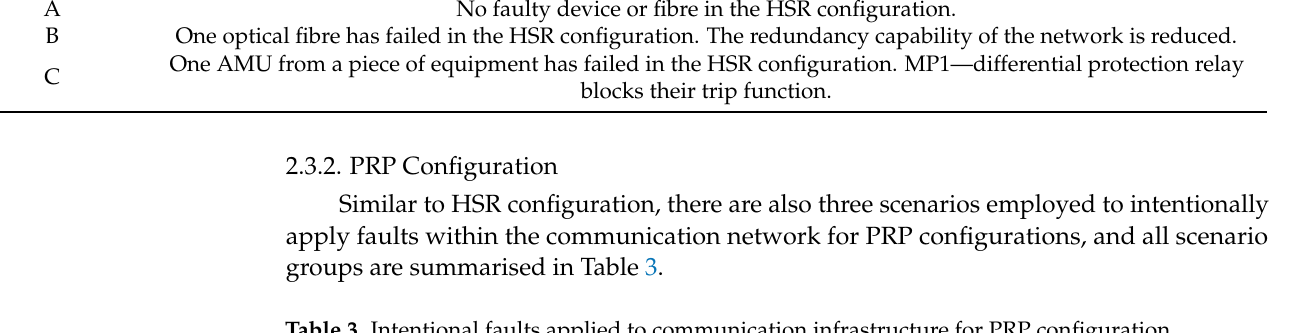
Table 3. Intentional faults applied to communication infrastructure for PRP